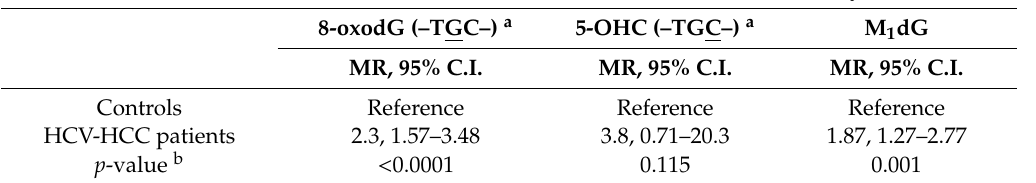
Table 2. Mean Ratio (MR) and 95% Confidence Interval (C.I.) of 7-hydro-8-oxo-2 (cid:48) -deoxyguanosine (8-oxodG) and 5-hydroxycytosine (5-OHC) at the codon 176 along the exon 5 sequence of the p53 gene among hepatitis C virus (HCV)-associated hepatocellular carcinoma (HCC) patients and controls. MR estimates of 3-(2-deoxy- β - d -erythro-pentafuranosyl)pyrimido[1,2- α ]purin-10(3H)-one deoxyguanosine (M 1 dG) are shown.